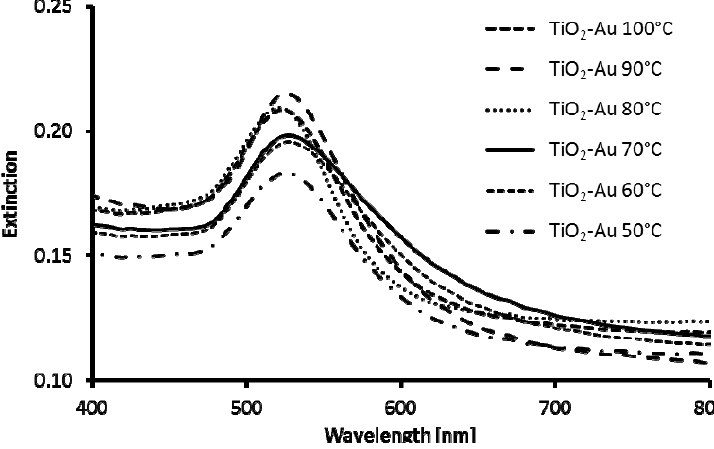
Figure 8. UV-Vis spectra of TiO 2 @Au nanostructures obtained by direct reduction of gold salts on functionalized TiO 2 particles at various temperatures: ( 11 ) 100 °C; ( 12 ) 90 °C; ( 13 ) 80 °C; ( 14 ) 70 °C; ( 15 ) 60 °C; and ( 16 ) 50